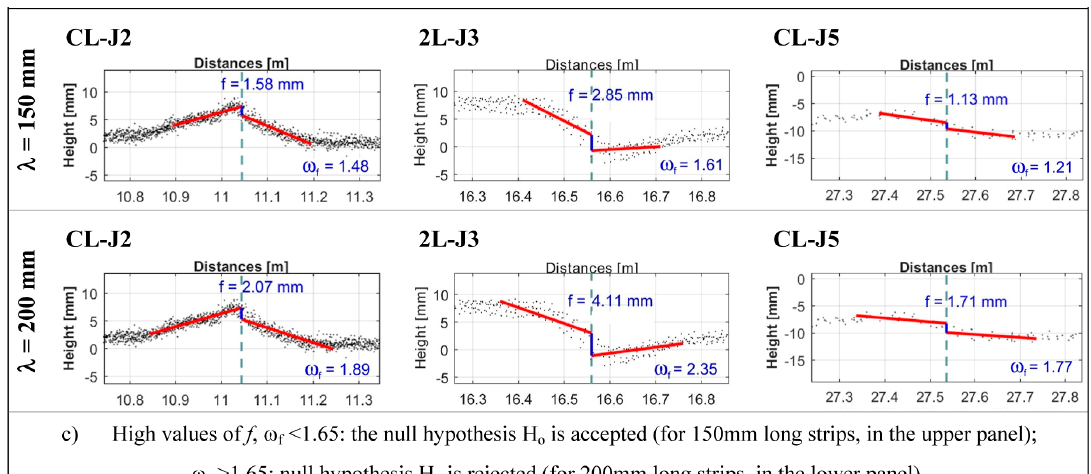
Figure 12. Display of the faulting values computed using the segments interpolating the point clouds for strips of 150 + 150 mm (upper panels) or 200 + 200 mm (lower panels) over the joints.